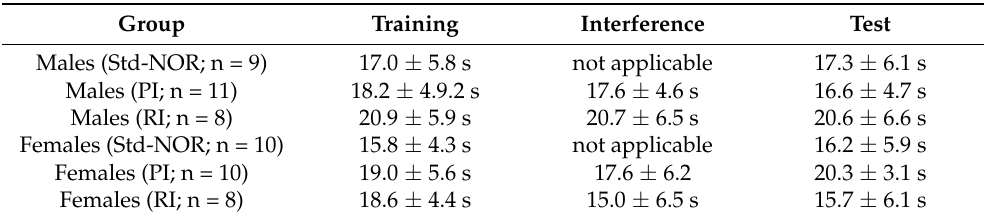
Table 1. Exploration time during training, interference, and test, relative to Figure 1. Std-NOR: standard novel object recognition; PrI: proactive interference; RI: petroactive interference. Group Training Interference Test Males (Std-NOR; n = 9) Males (PI; n = 11) Males (RI; n = 8) Females (Std-NOR; n = 10) Females (PI; n =